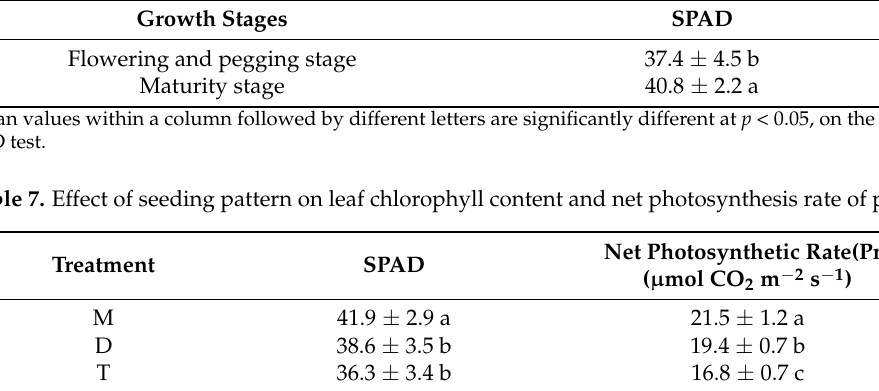
Table 6. Effect of different growth stages on leaf SPAD value of peanut.